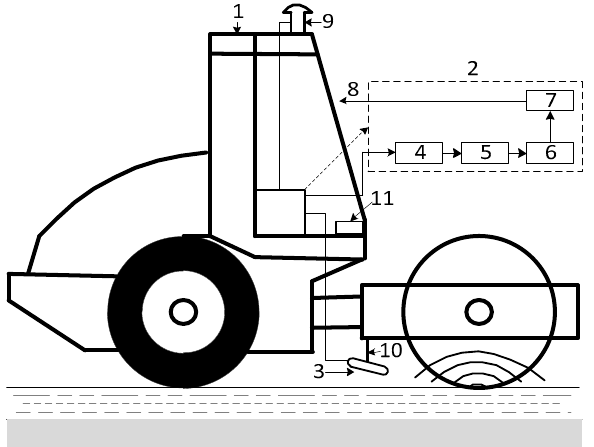
Figure 9. Schematic diagram of acoustic wave detection technique.